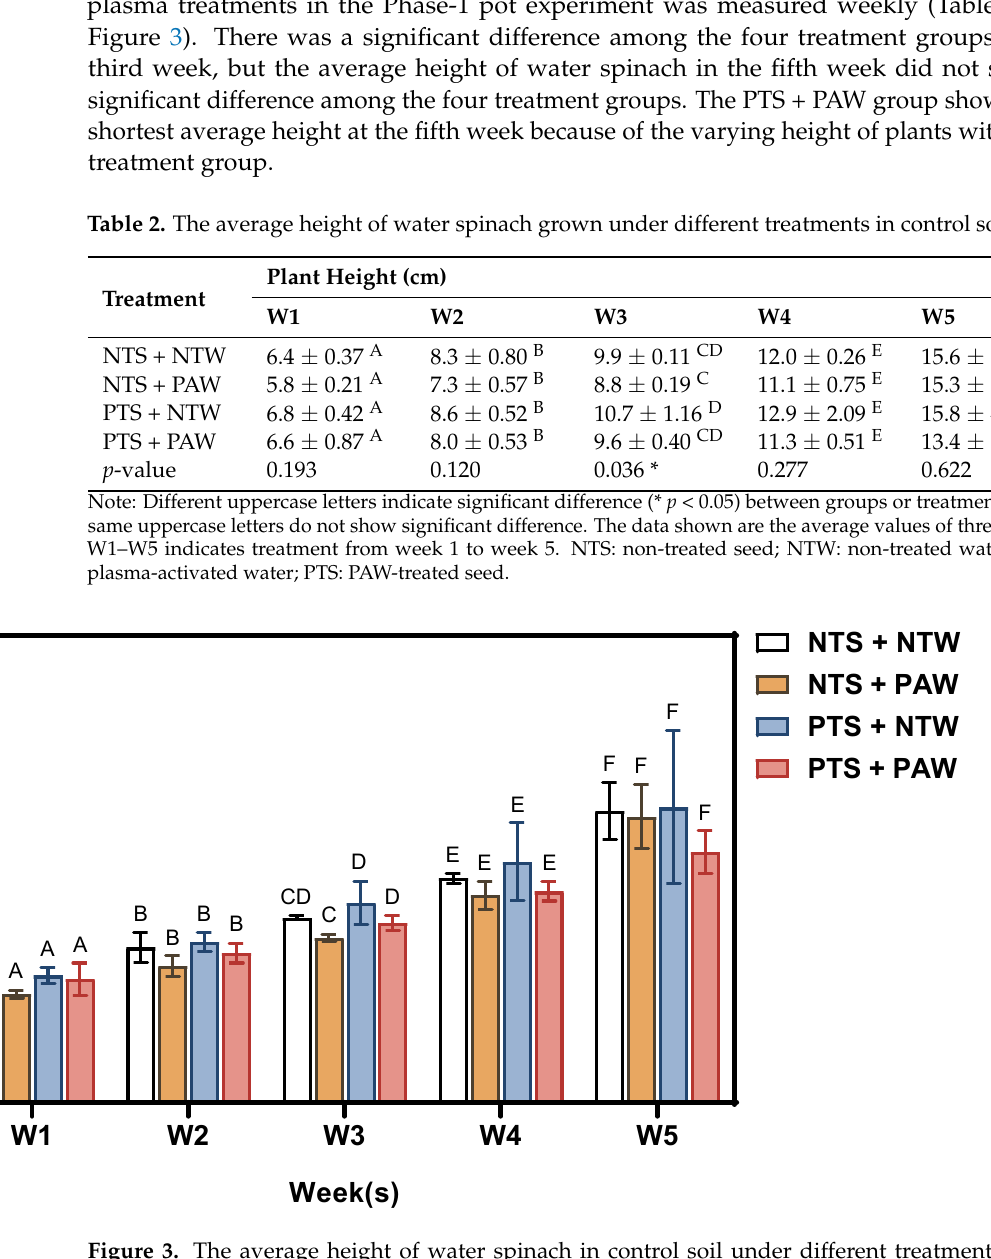
Table 2. The average height of water spinach grown under different treatments in control soil.